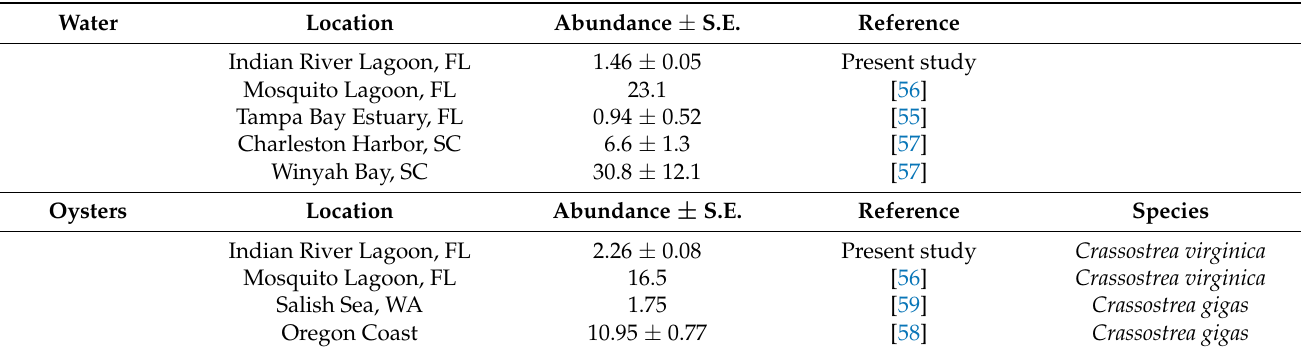
Table 4. Comparison of microplastic abundance in water and oysters from the Indian River Lagoon and other estuaries in the United States. Values reported are mean abundance per liter of water, microplastics per individual oyster, and standard error of the